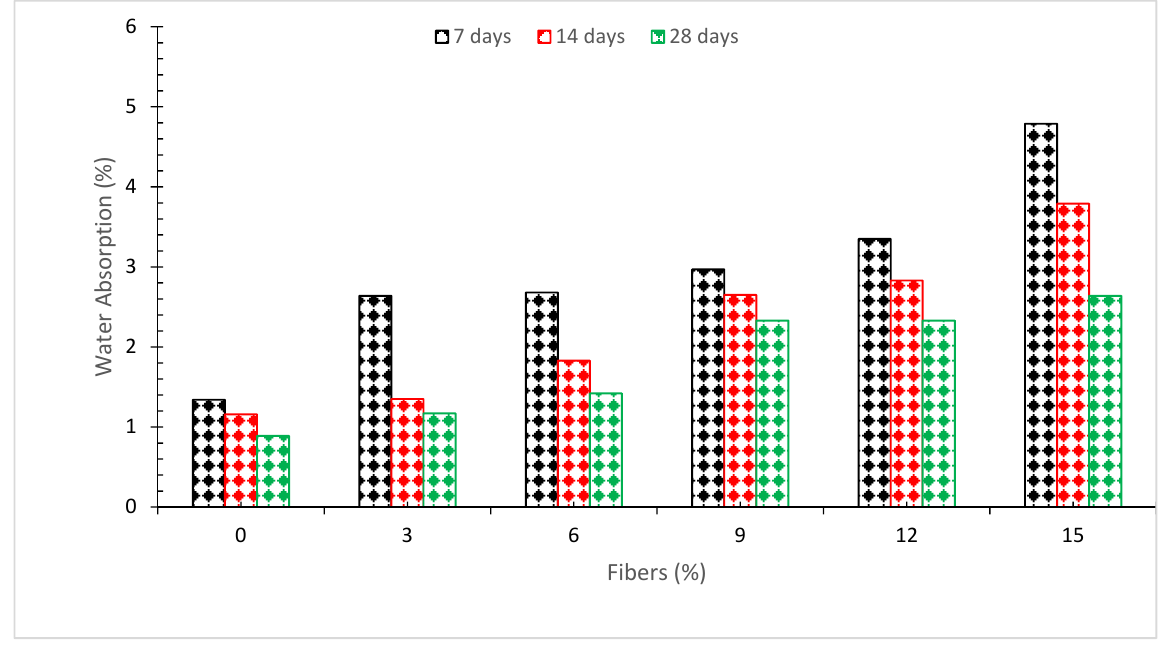
Figure 13. Water absorption [73].